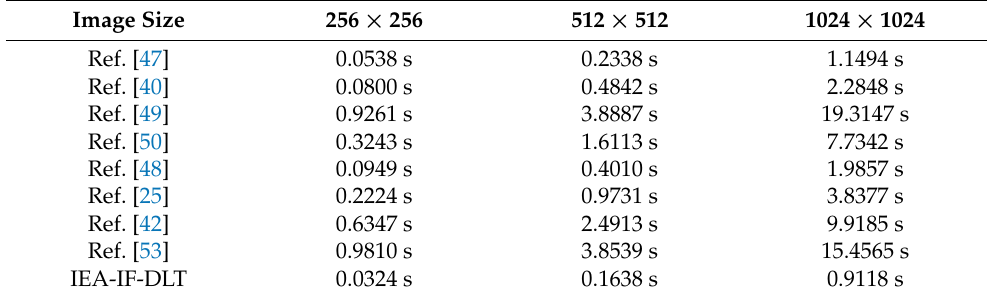
Table 8. Times (in seconds) required by different encryption algorithms to encrypt images of four common